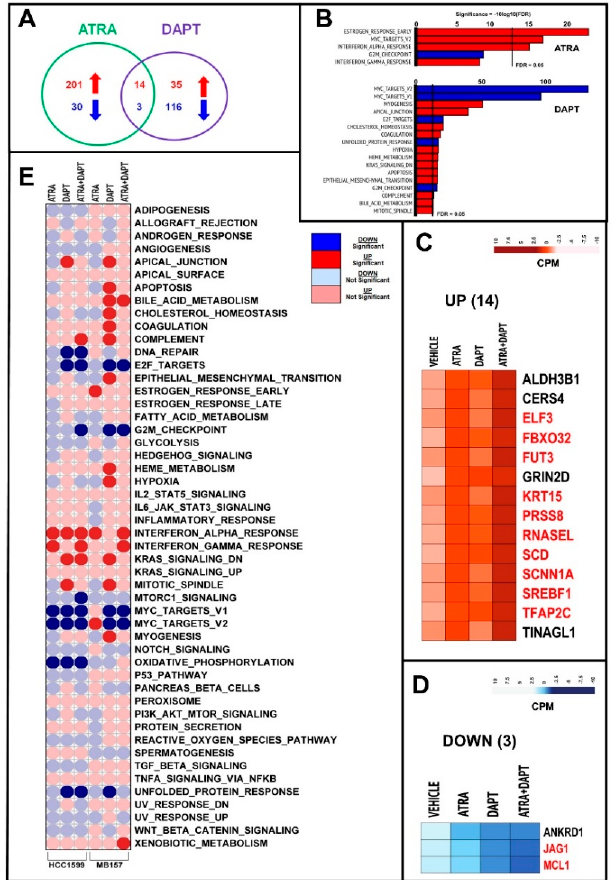
Figure 7. RNA-seq analysis of MB-157 cells exposed to ATRA, DAPT and ATRA + DAPT. Three paired biological replicates of MB-157 cells were grown in DMEMF12 medium containing 5% charcolated FBS (Fetal Bovine Serum, Gibco) for 24 h. Cells were treated with vehicle (DMSO), ATRA (1 μ M), DAPT (1 μ M) or the combination of ATRA and DAPT (ATRA+DAPT) for another 8 h. RNA was extracted and subjected to RNA-seq analysis. ( A ) The Venn diagram illustrates the number of genes significantly up-regulated (red) and down-regulated (blue) by ATRA and DAPT (see also Table S1). ( B ) The panels show the top Hallmark pathways significantly enriched for genes up-regulated (red)